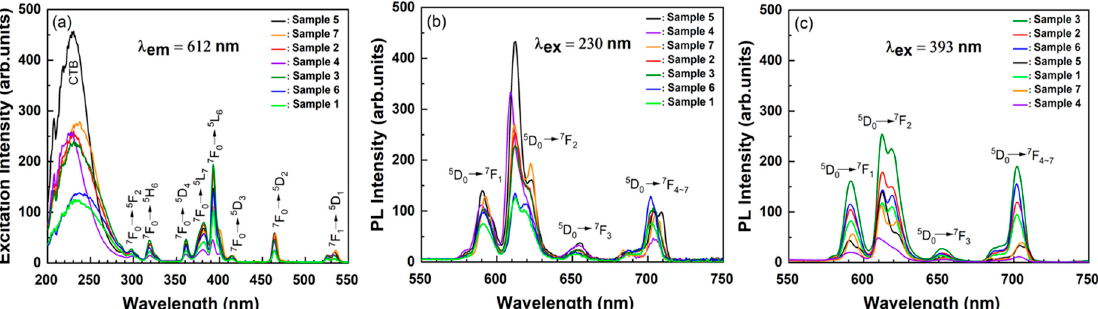
Figure 2. Excitation spectra ( a ) obtained by monitoring the emission at 612 nm, emission spectra at an excitation wavelength of ( b ) 230 nm and ( c ) 393 nm for Ba 0 . 96 SiO 3 :0.02Eu 3+ , 0.02R +/3+ phosphors (samples 1–7).